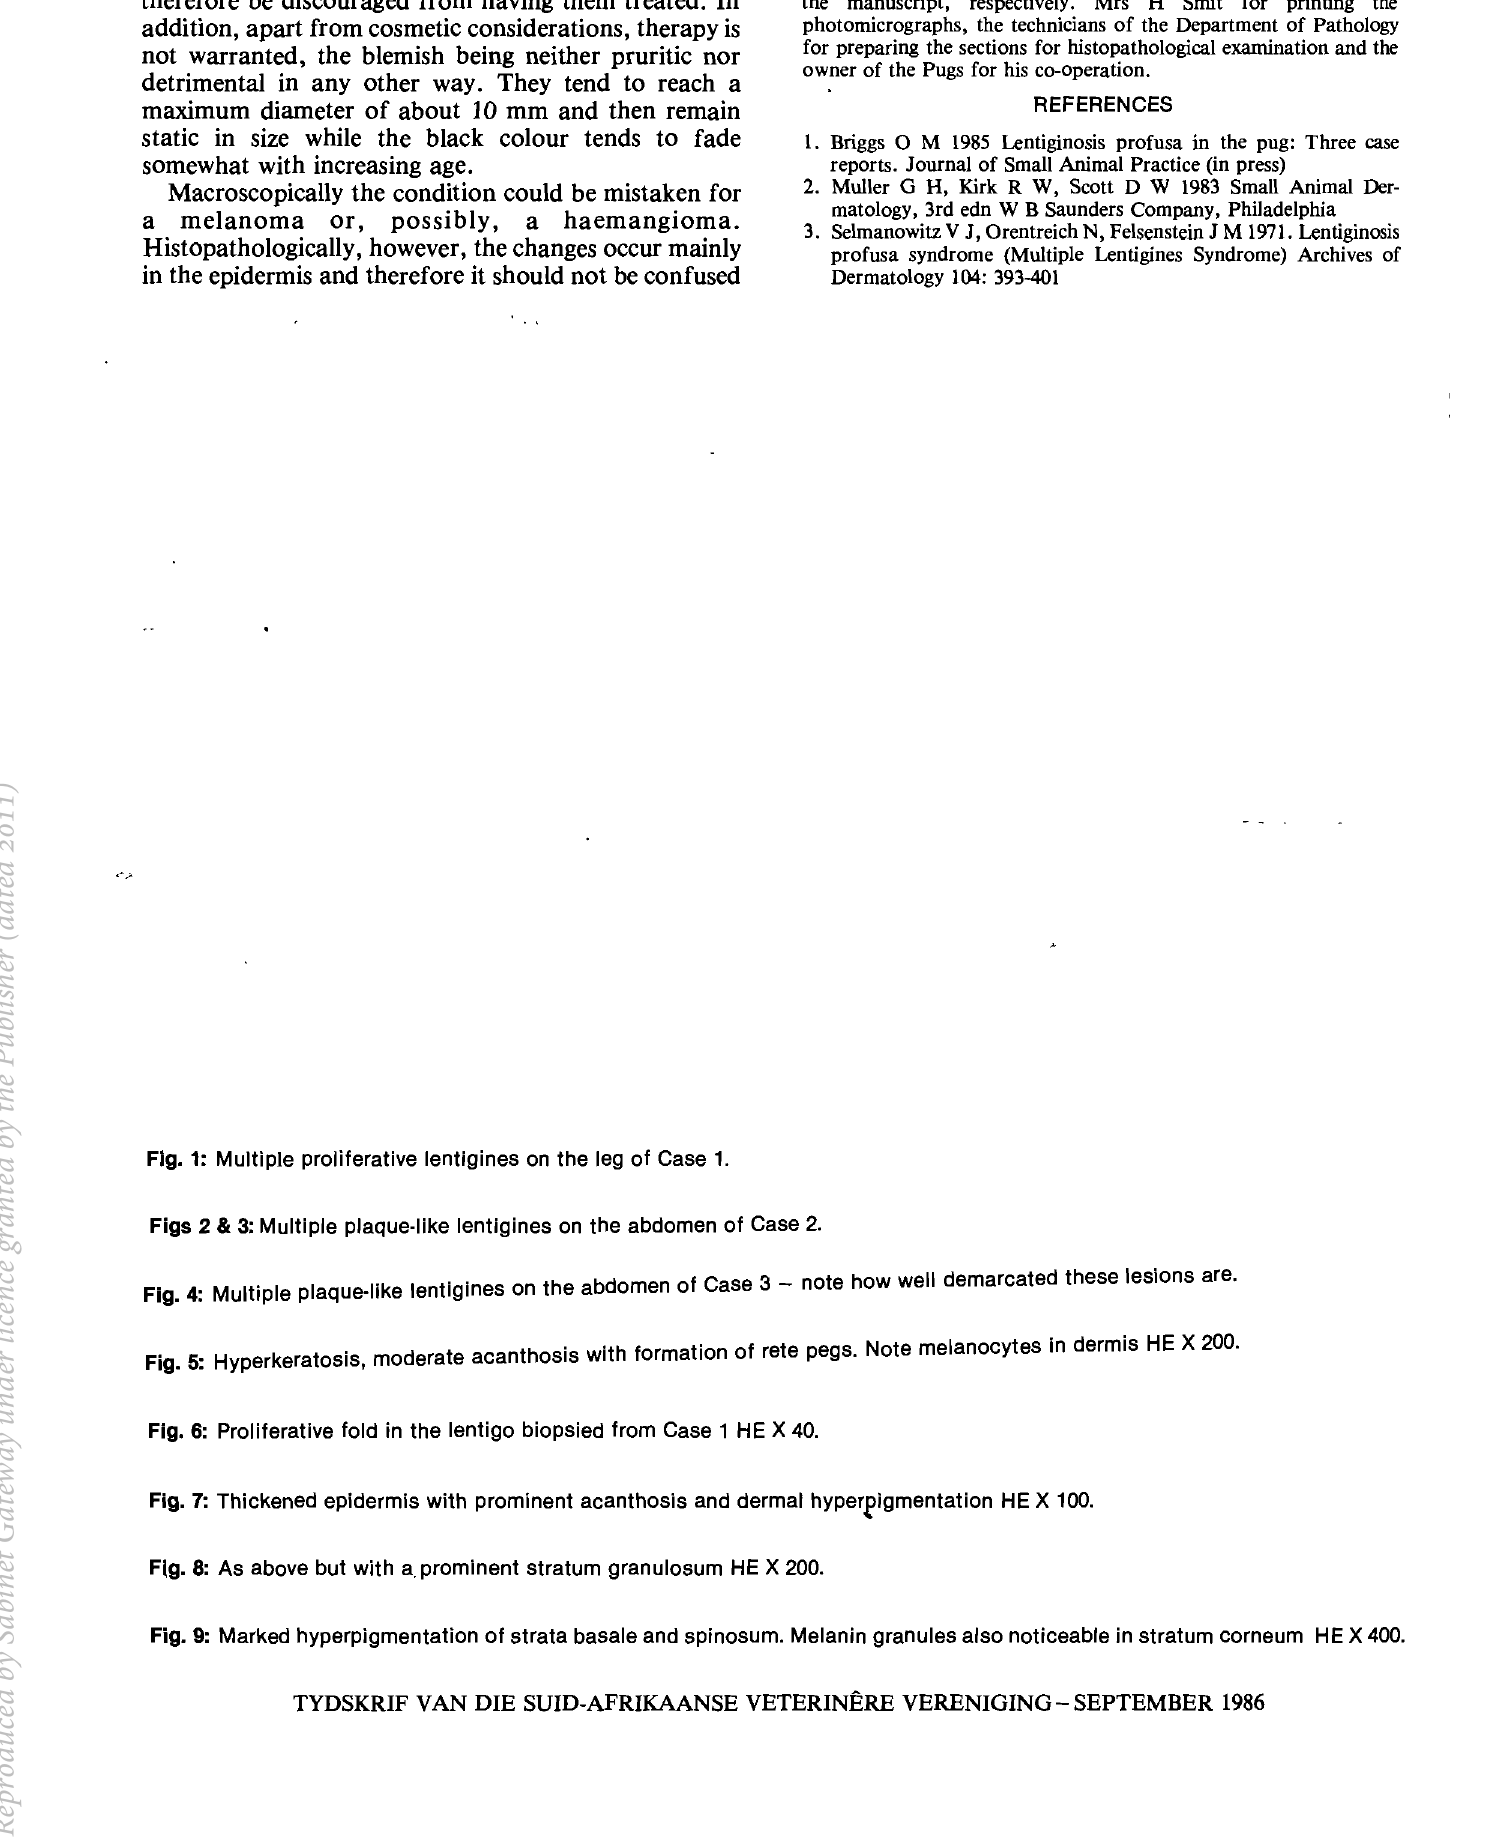
Fig. 1: Multiple proliferative lentigines on the leg of Case 1. Figs 2 & 3: Multiple plaque-like lentigines on the abdomen of Case 2. Fig. 4: Multiple plaque-like lentigines on the abdomen of Case 3 - note how well demarcated these lesions are. Fig. 5: HyperkeratosiS, moderate acanthosis with formation of rete pegs. Note melanocytes in dermis HE X 200.